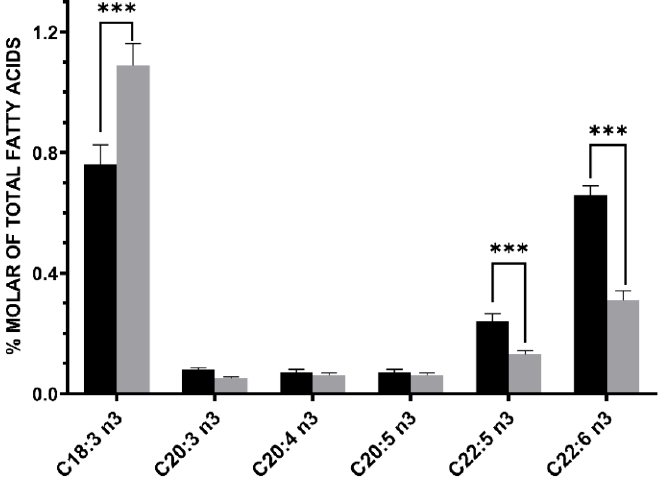
Figure 1. Differences in n-3 PUFAs between donor human milk (grey bar) and colostrum of mothers of preterm infants of <32 weeks’ gestation) (black bar). Donor human milk showed higher levels of α-linolenic acid (C18:3 n3, +43.4%) and about −53.0% lower levels of docosahexaenoic (DHA) acid (C22:6 n3). Asterisks indicate significant differences (*** p < 0.001) between the different groups.